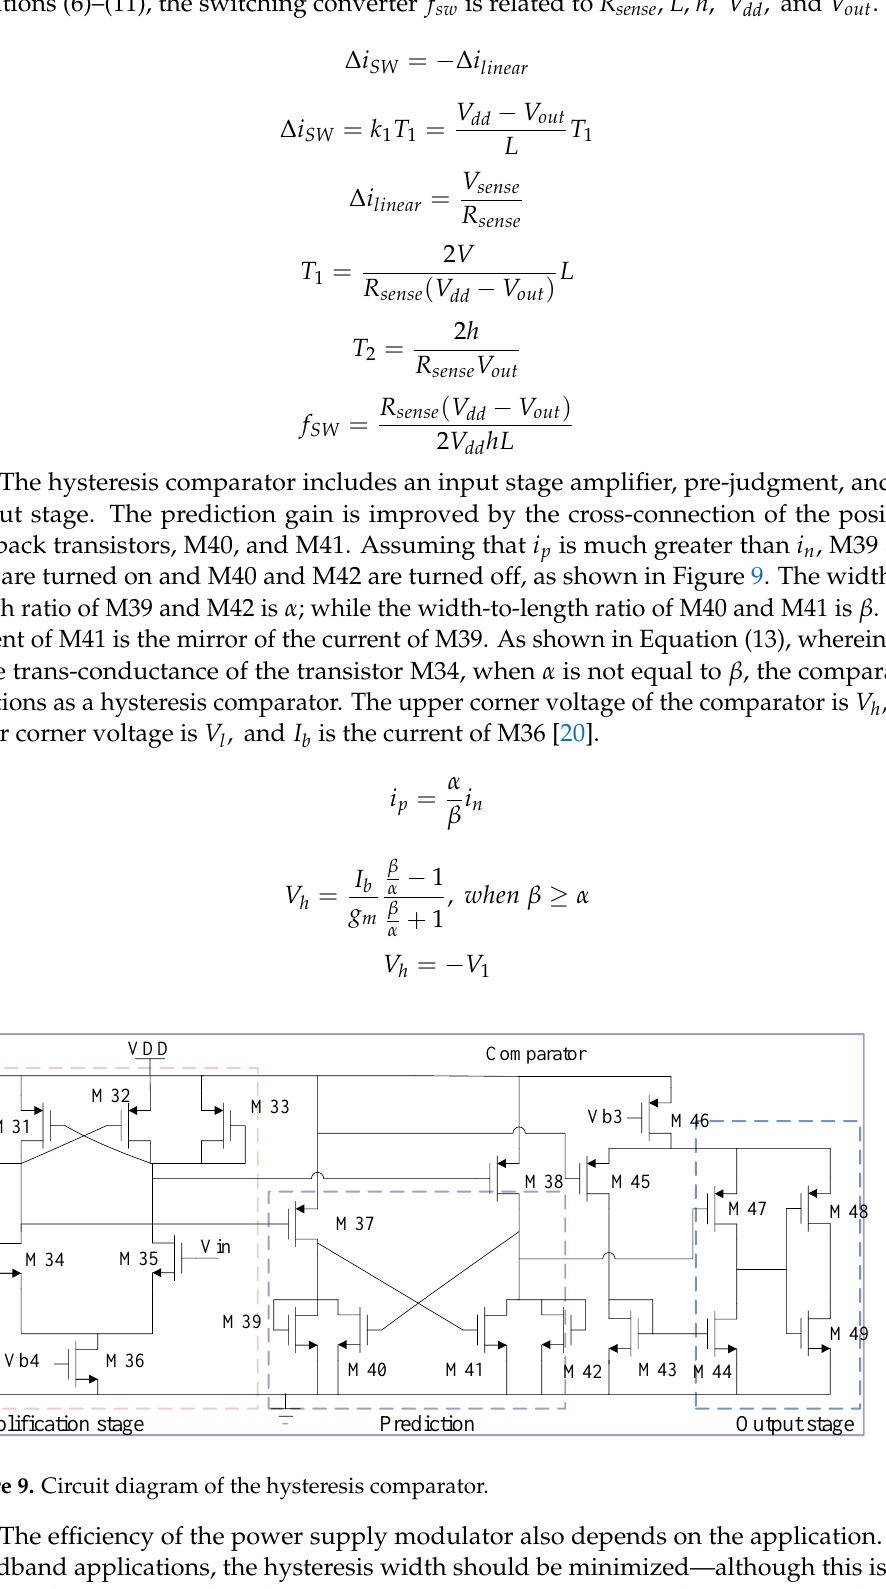
W t+1 Figure 10. Procedure and simplified circuit model of a hybrid power supply modulator. 3. Results and Discussion All circuits as shown in Figure 11 are fabricated in a 0.18 μm Complementary Metal Oxide Semiconductor (CMOS) technology package. Circuits are simulated by Cadence software.